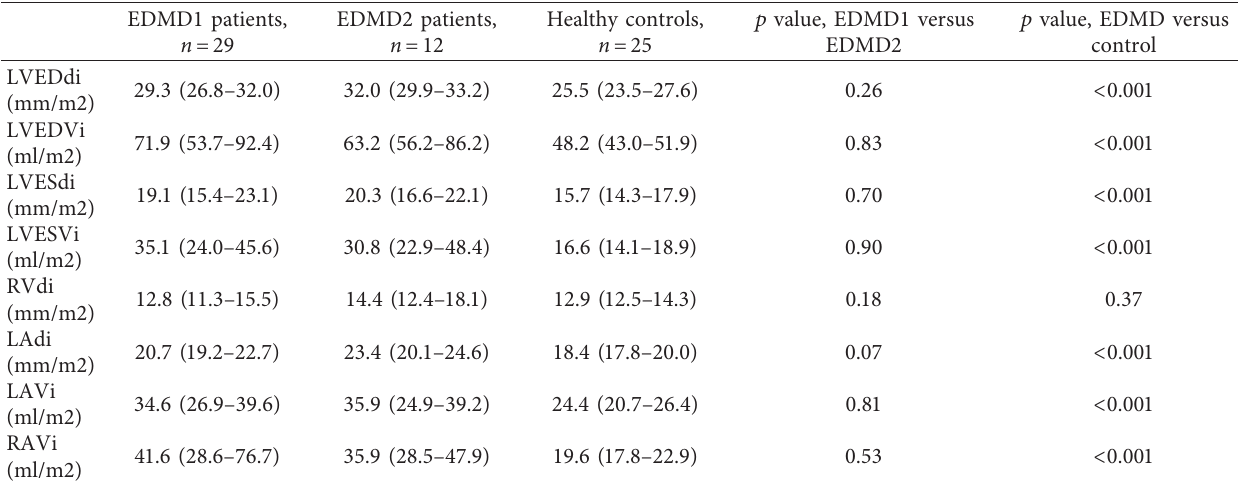
Table 2: Cardiac chamber diameters and volumes of EDMD patients and healthy